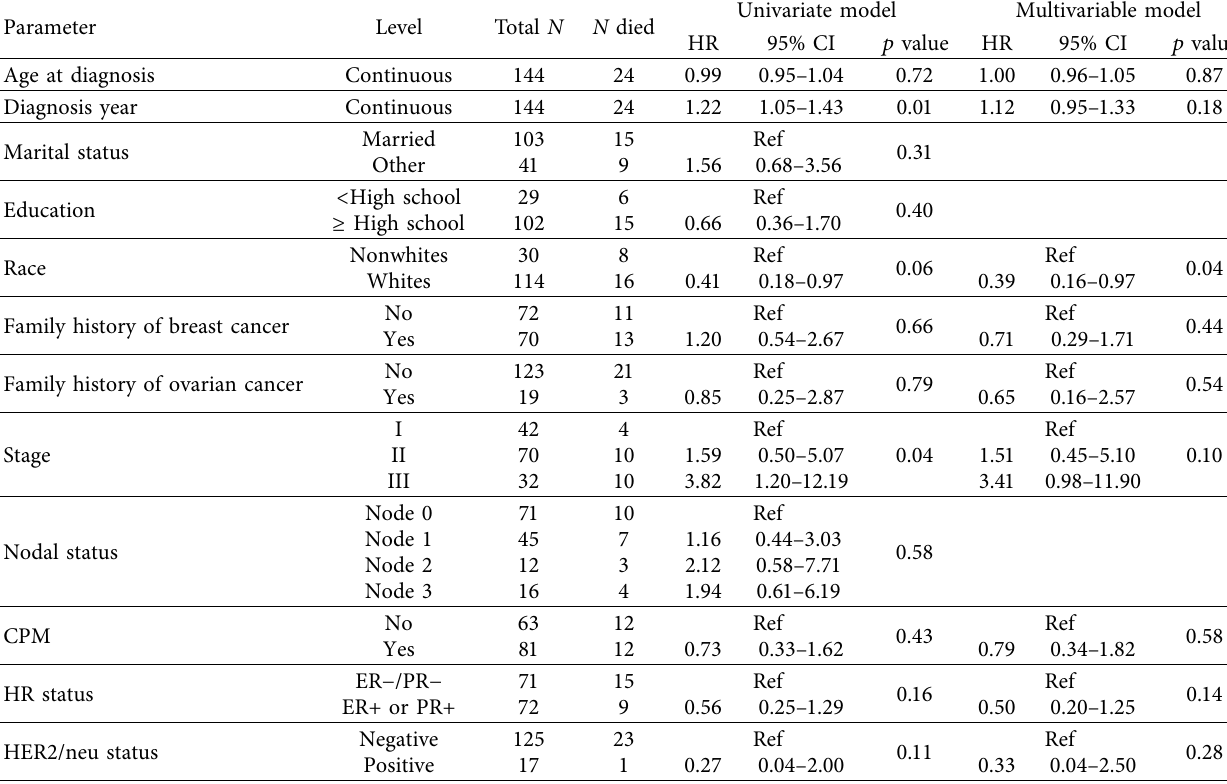
Table 3: Adjusted and unadjusted cox regression model for overall